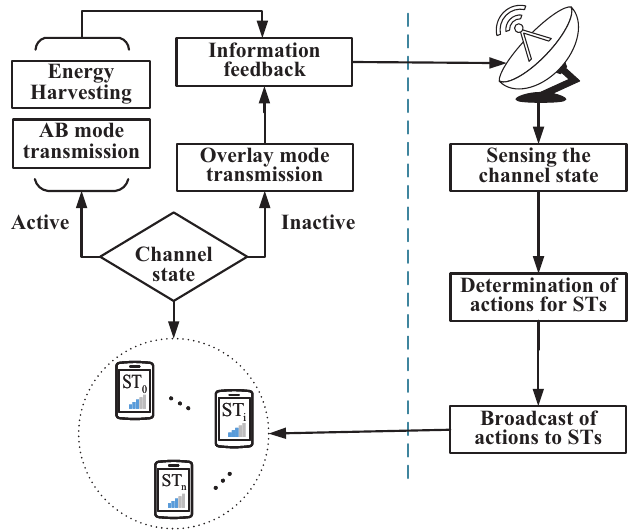
= 1. ( c ) depicts the system model when s a t = 0. t